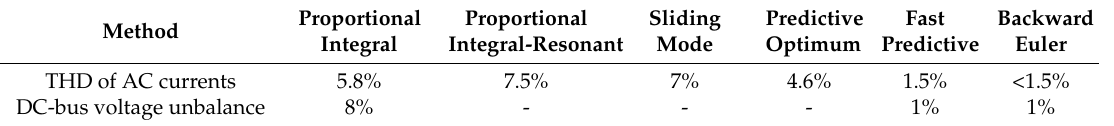
Table 8. Backward Euler stabilized controller compared with existing control